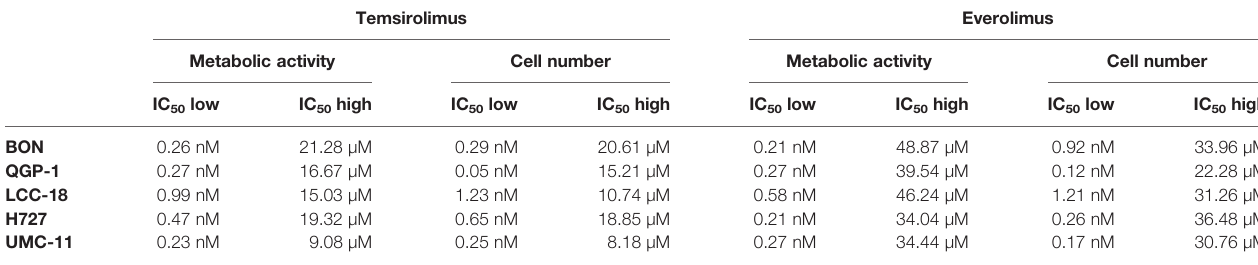
TABLE 1 | Summary of IC 50 values for mTOR